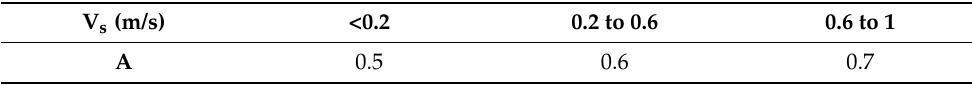
Table 7. Radiant fraction as a function of airspeed